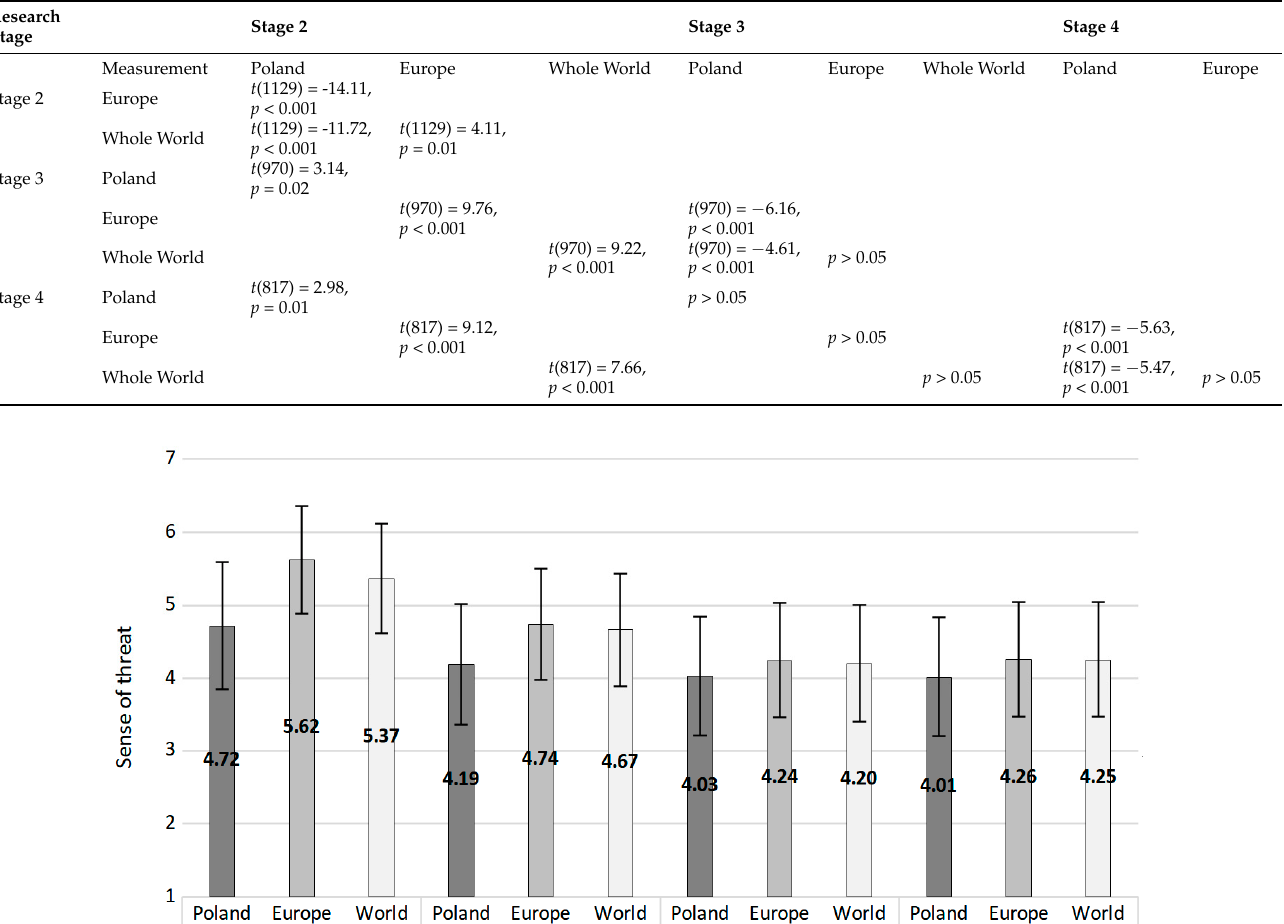
Table 3. t -test comparisons within the interaction of distance and study stage.